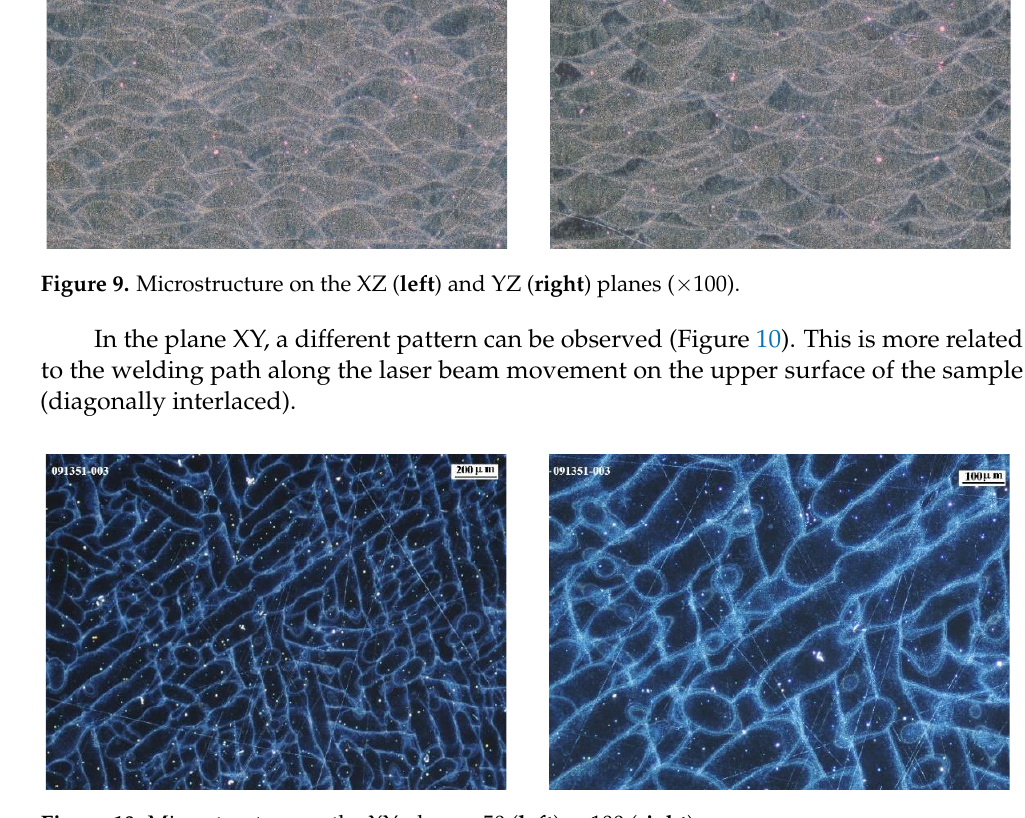
Figure 10. Microstructure on the XY plane × 50 ( left ), × 100 ( right ). To have a closer view of the microstructure, samples were observed in a scanning electron microscope. The images (Figure 11) showed a needle-like structure (eutectic type) quite typical in fast-cooled metals. These needles appear finer in the core of the weld seam and slightly coarser in the border of adjacent seams.